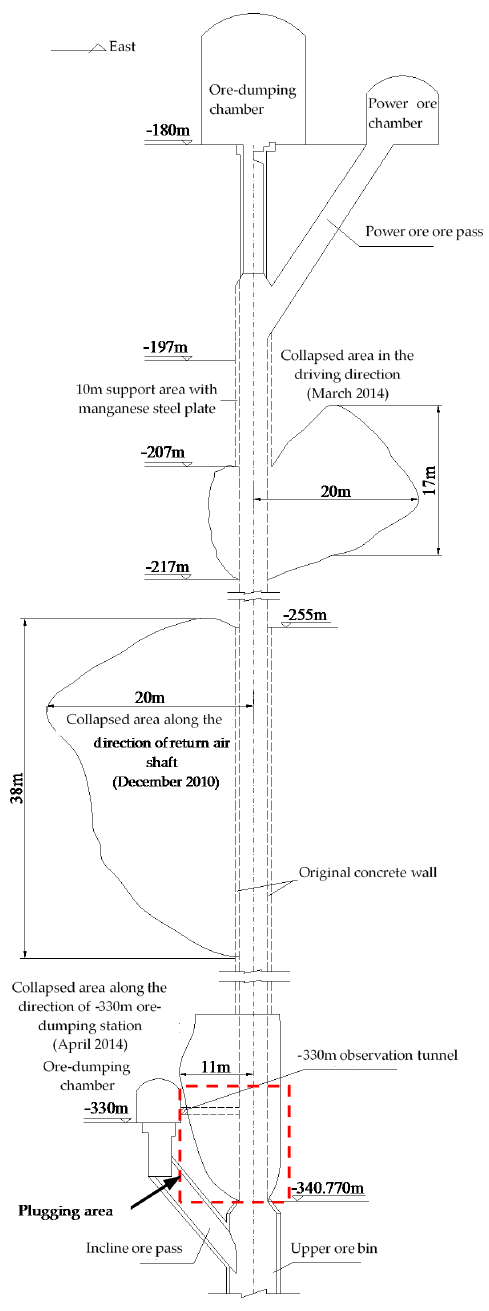
Figure 10. Collapse shapes of the main ore pass.